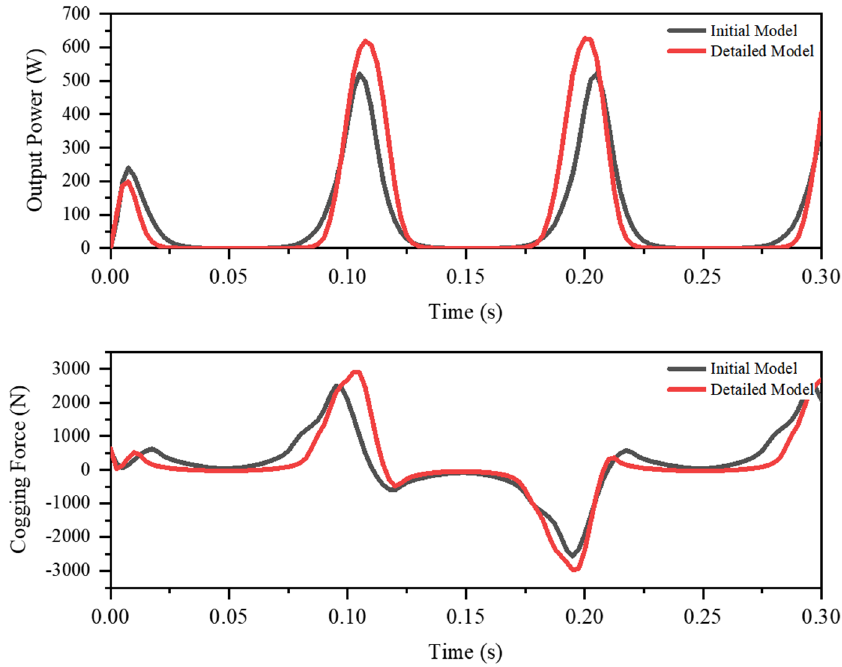
Figure 9. Output power and Cogging force of the Initial and the Detailed Model.